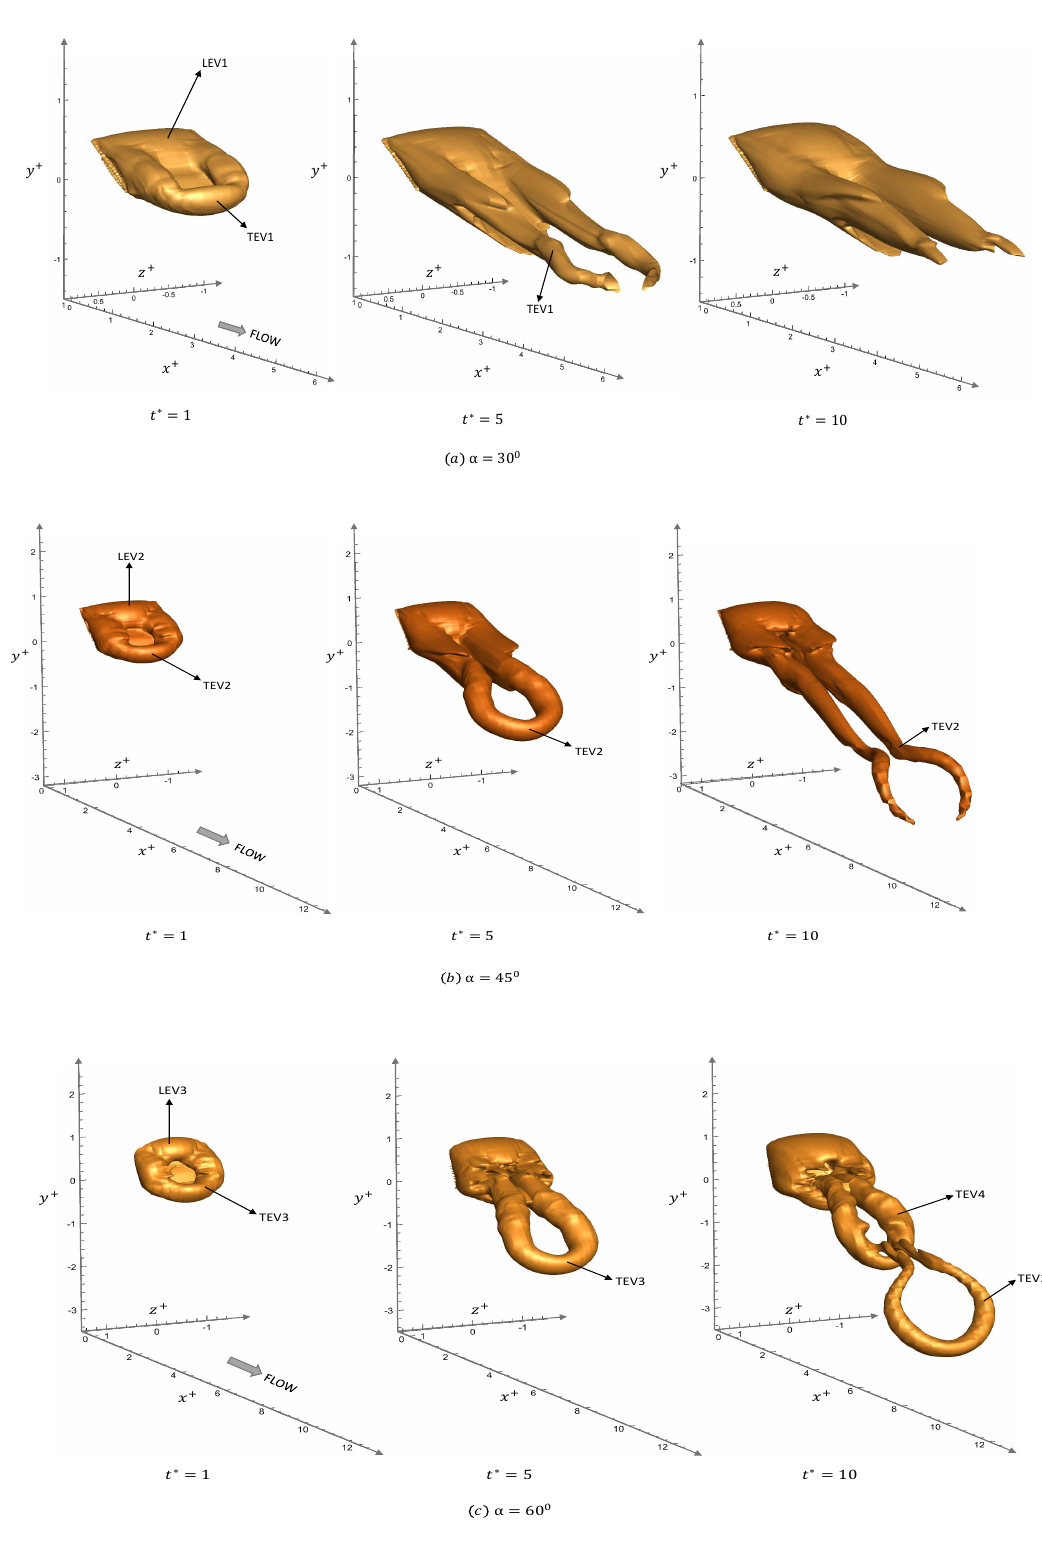
Figure 8. Iso-surfaces of vorticity magnitude ( | ω ∗ | = 1.62, 1.65 and 2.14), for cases of α = 30 deg, 45 deg and 60 deg